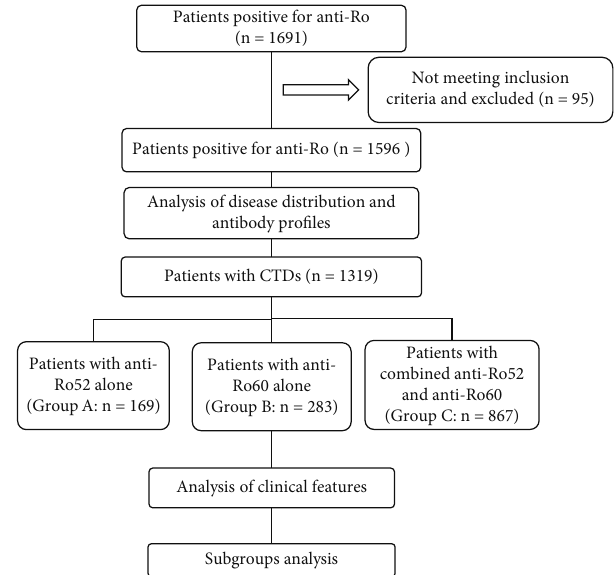
Figure 1: Flow chart of patient inclusion and